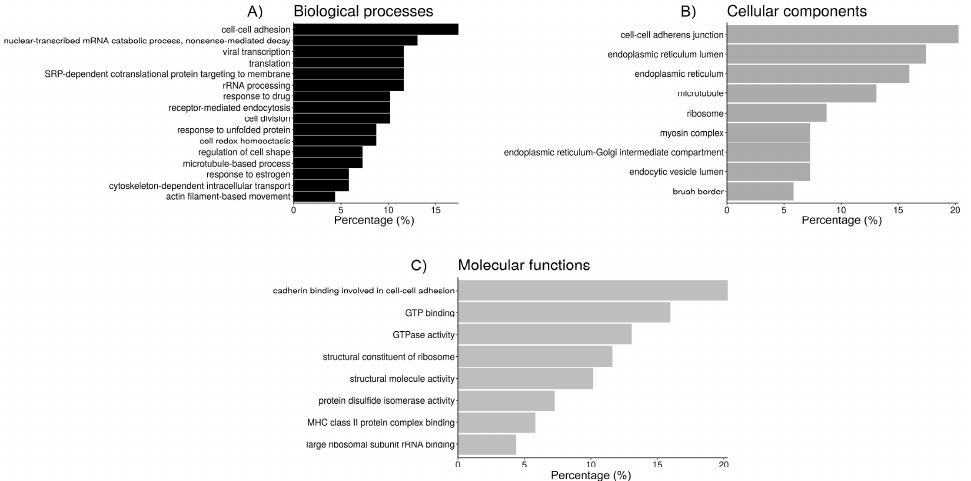
Figure 3. Bar chart representing the distribution of the proteins identified in spermatozoa incubated with oviductal fluid (OF) according to the biological process ( A ), cellular component ( B ), and molecular function ( C ).